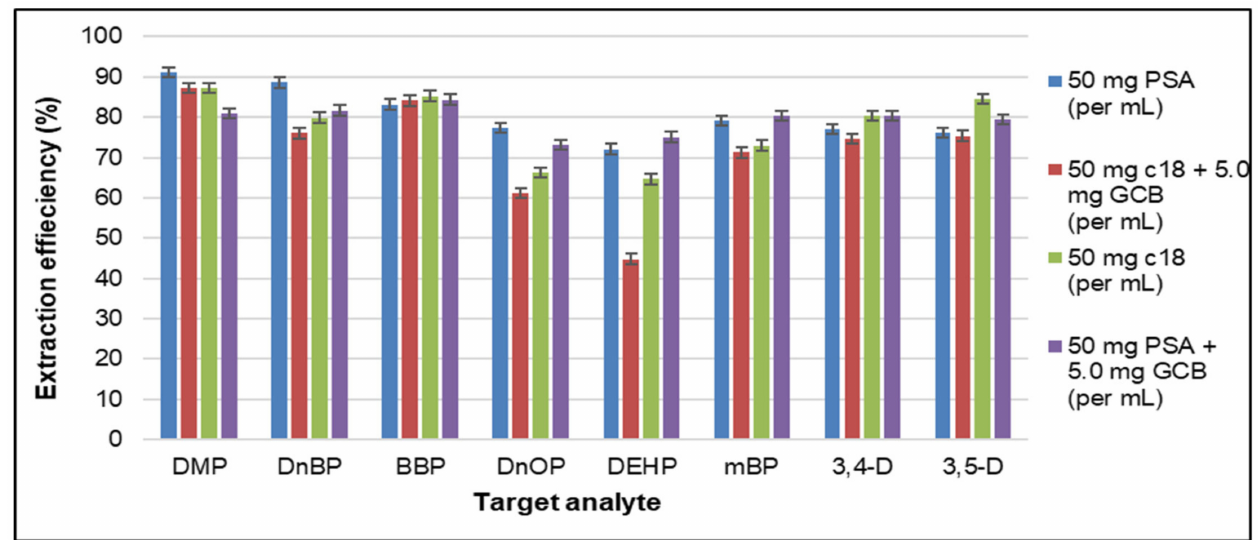
Figure 2. Rice sample QuEChERS cleanup efficiency, using different sorbents in fortified rice samples at the 0.25 mg/kg